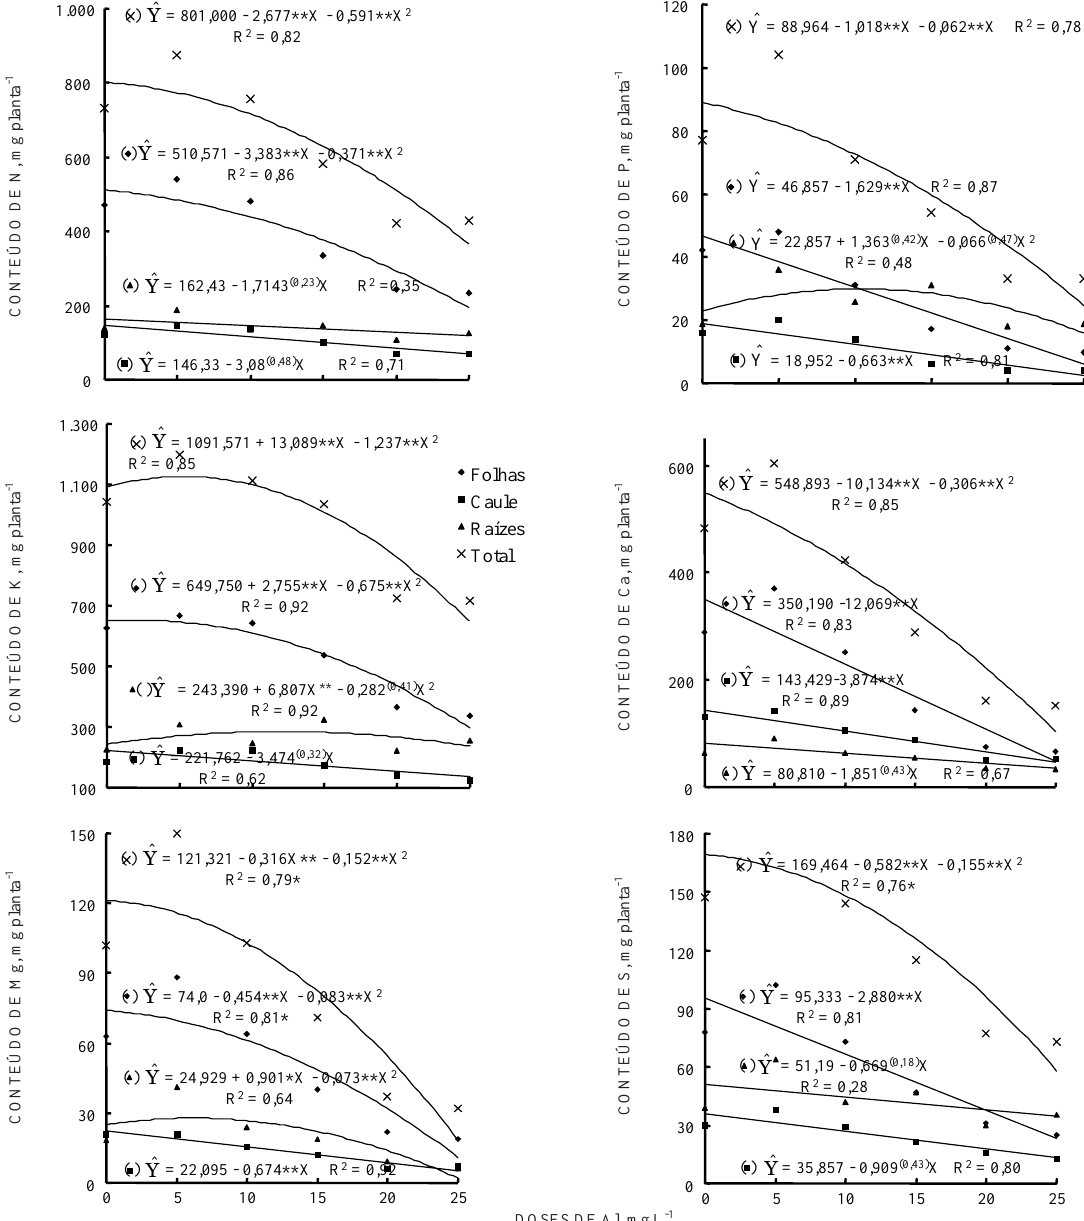
DOSES DE Al, mg L Figura 2. Conteúdo de macronutrientes nas folhas, caule, raízes e total nas mudas de goiabeira de acordo com as doses de alumínio (* e ** significativos a 5 e 1% e os valores entre parênteses representam a significância dos coeficientes de regressão não significativos nem a 5%).